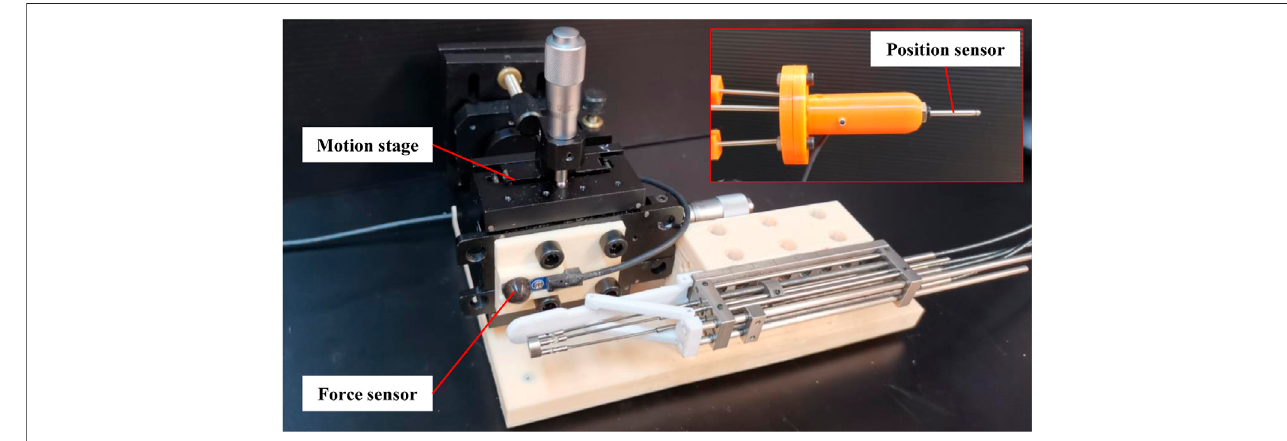
FIGURE 3 | Setup for the pressure tests of the tongue depressor.